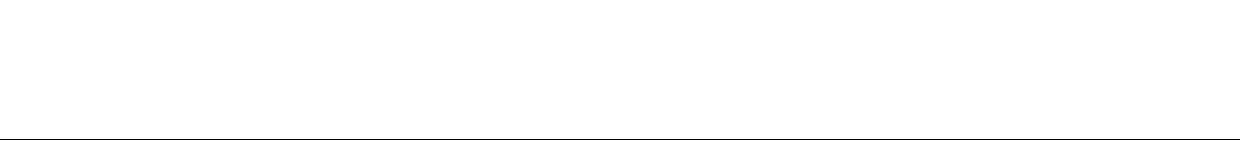
TABLE 1 | Chromosome (BTA), start and end position (bp), and number of signi fi cant and suggestive single nucleotide polymorphisms (SNPs) within the imprinted QTLs associated with carcass weight, as well as SNP name, position, imprinting effect, p -value, nearest gene within 0.5 Mb and annotation of the lead SNP. BTA QTL region Lead SNP in QTL region Start